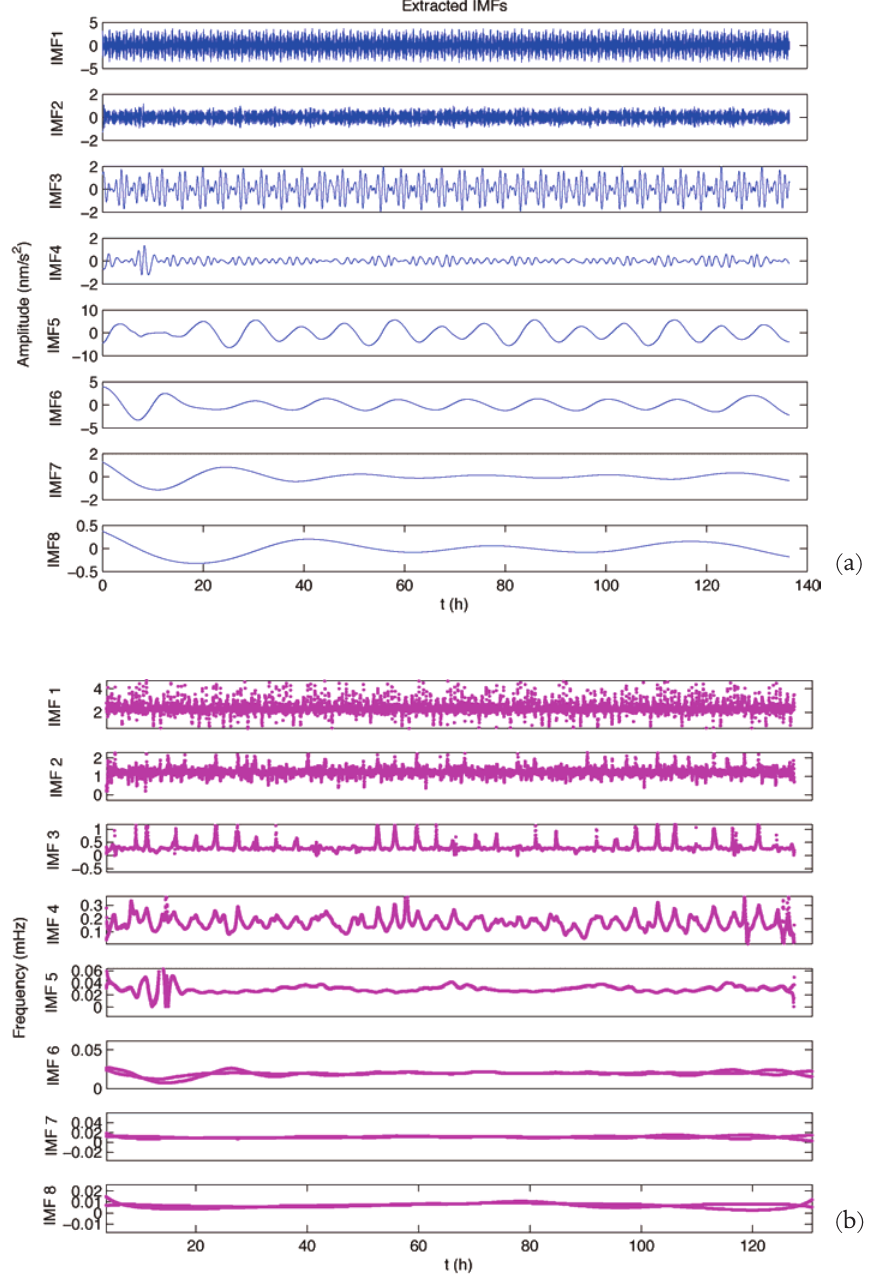
Figure 1. Illustration of the Hilbert-Huang transformation using synthetic data. (a) Eight IMFs labeled by the sequences they are sifted, which are decomposed from the synthetic signal with frequencies IMF1-8 (2.5, 2.1, 1.92, 1.2, 0.31, 0.24, 0.03, 0.02) mHz, and amplitudes (1.5, 1.3, 0.8, 0.55, 0.7, 1.0, 4.0, 3.0) nm/s 2 , respectively. (b) Instantaneous frequencies corresponding to each of IMF1-8 according to